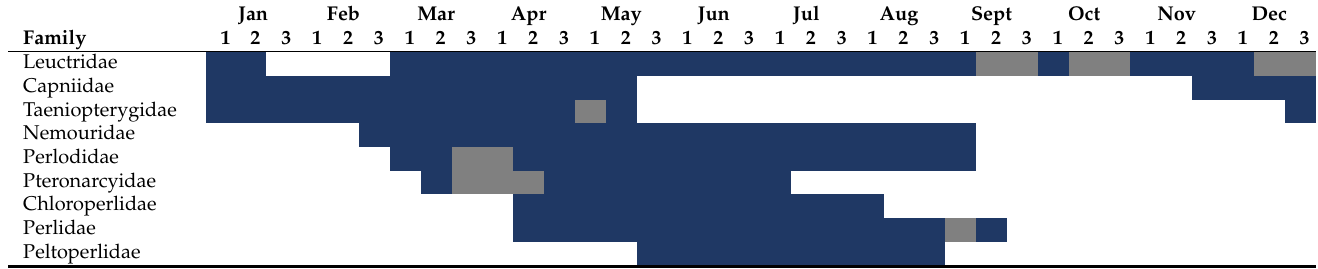
Figure 6. Boxplot of longitude associated with collection locations for each Maryland stonefly family. Boxes represent the interquartile range, while vertical lines extend to the minimum and maximum values. The horizontal line within the interquartile range represents the median longitude. Outliers are shown with large, solid circles. Small, individual points overlaid on each boxplot illustrate the distribution of observations. Table 3. Recorded adult presence for Maryland stonefly families. Months are broken into three 10-day periods. Dark blue squares represent periods with positive collection data. Gray squares represent periods between positive collections when species may be